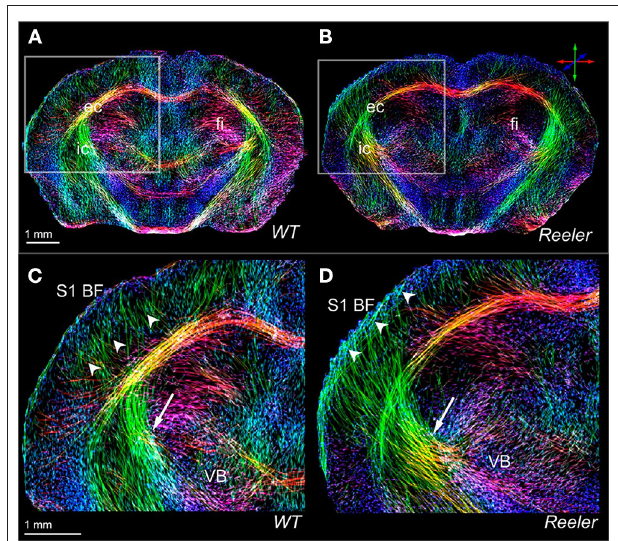
FIGURE 2 | High-resolution views of the thalamocortical fiber architecture of the wild-type and reeler mouse brain. In vivo high-resolution fiber maps of normal (A,C) and reeler (B,D) brain captures major features of normal (C) vs. remodeled (D) subcortical (arrows) and thalamocortical (arrow heads) fiber trajectories of the somatosensory thalamocortical pathway. The magnified views (C,D) illustrate the fiber bundles emerging from the ventrobasal thalamic nucleus (VB) to target S1BF (S1 barrel field); they cross the internal capsule ( C,D , arrow) and gather beneath the cortical gray matter before extending intracortically up to presumptive layer IV of the wild-type S1BF ( C , arrow heads). Note that the reeler thalamic fibers (D) are defasciculated to form a broader array projecting diagonally ( D , arrow) into the cortical areas. Reproduced with permission from Harsan et al.